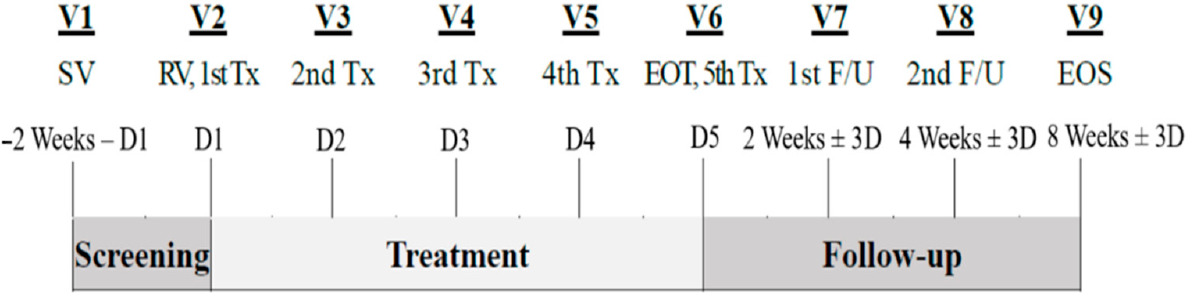
Figure 2. Study design: D, day; EOS, end of study; EOT, end of treatment; F/U, follow ‐ up.